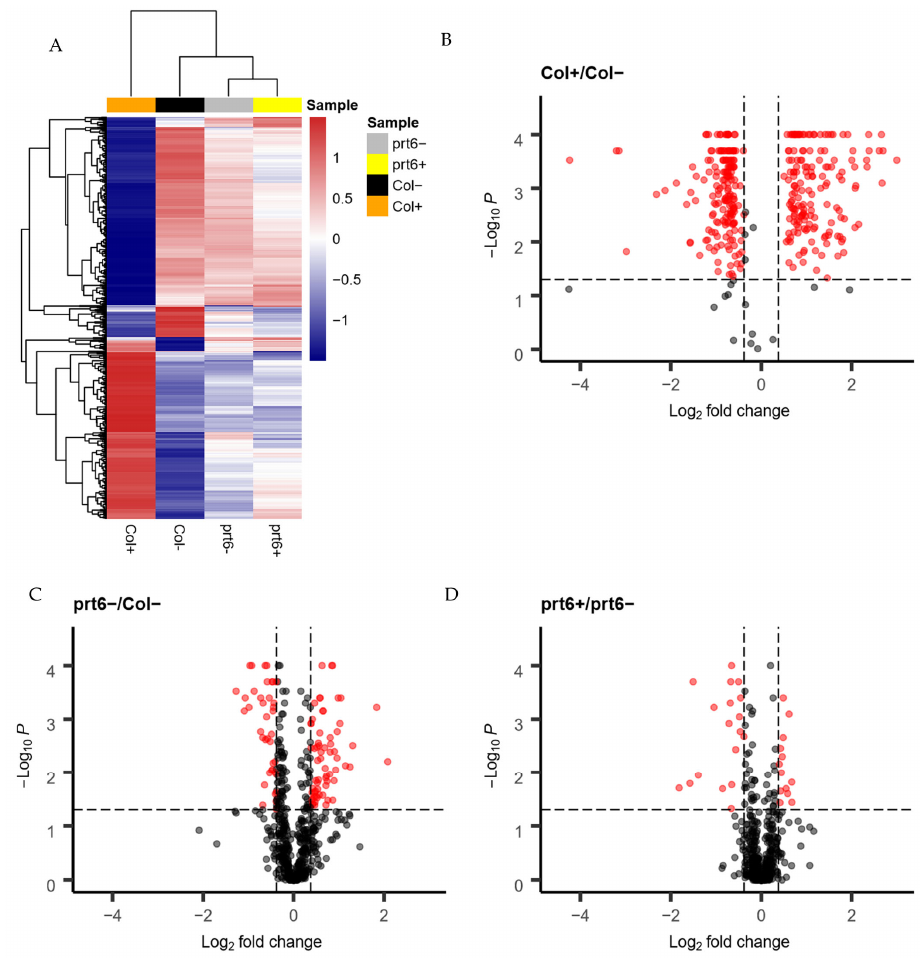
Figure 3. Expression patterns of the 619 DEPs estimated by XIC abundance. ( A ): The hierarchical clustering analysis of the 619 DEPs in Col+, Col − , prt6 +, prt6 − . In the heatmap, blue represents down-regulated expression, red represents up-regulated expression and white represents no change in expression. ( B – D ): The volcano plots representing the quantitative analysis of 619 proteins in Col+ versus Col − ( B ), prt6 − versus Col − ( C ), prt6 + versus prt6 − ( D ). X -axis and Y -axis represents the log 2 (fold ratio) and − log 10 ( p ), respectively. Red dots indicate that the proteins have significant differences ( p < 0.05, and fold change < 0.7 or fold change > 1.3), but the threshold of fold change was shown as |log2 (fold ratio)| > 0.4 in the plot), while the black dots correspond to proteins with no significant differences. The horizontal dashed line represents p = 0.05, namely, − log 10 ( p ) = 1.3. The two vertical dashed lines correspond to log 2 (fold change) = 0.4. Seeds harvested in